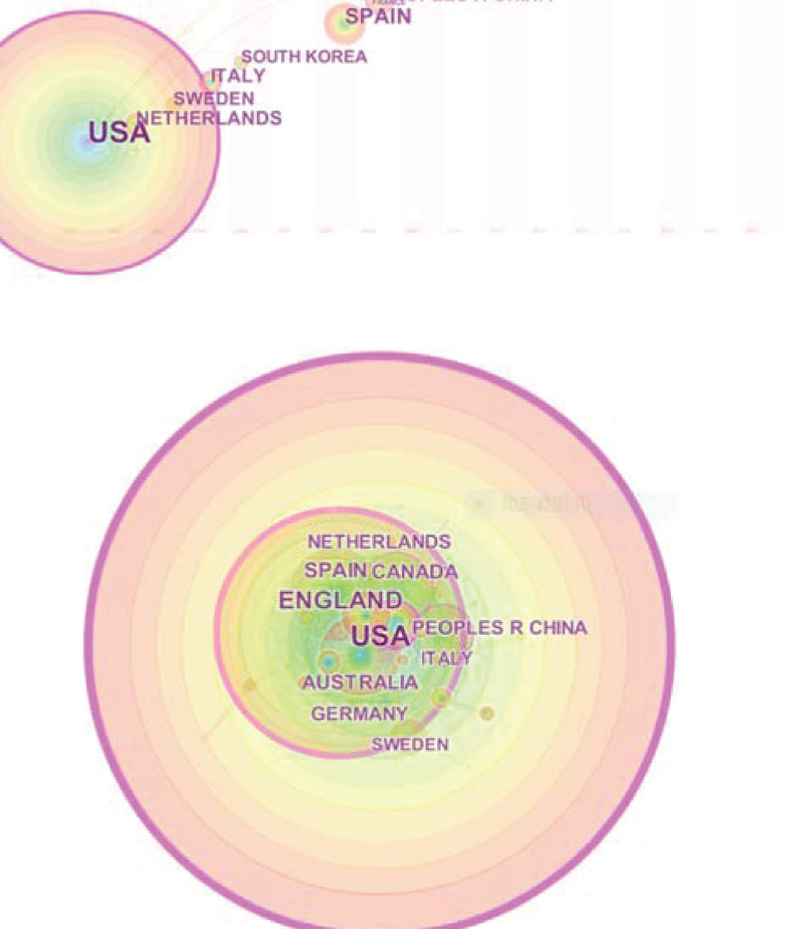
Figure 8. Cooperation